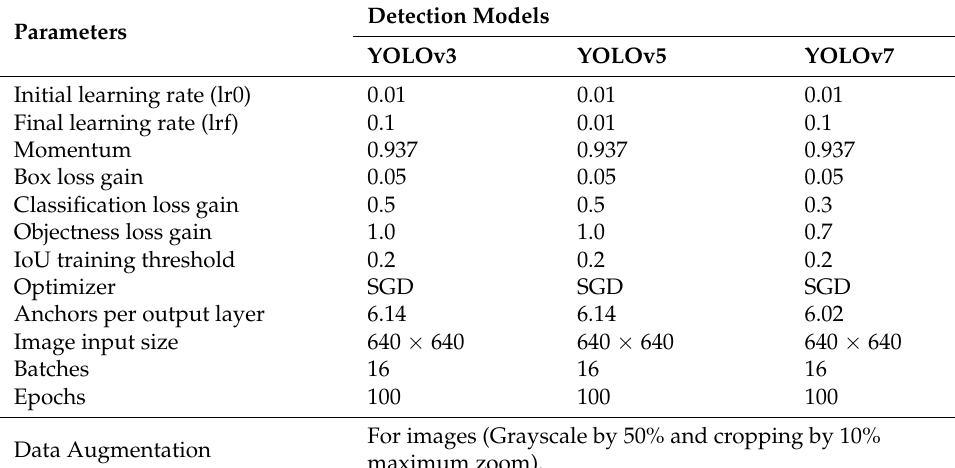
Table 4. Hyperparameter Tuning and Data-Augmentation Processing.